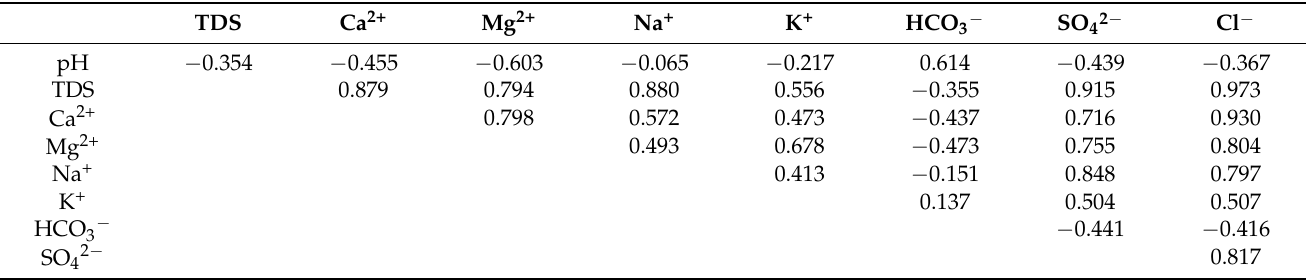
Figure 2. Boxplots of physicochemical parameters and major ions in EOC, NS, and FB aquifers. Table 2. PCC for pH, TDS (mg/L), and major ions (mg/L) in EOC, NS, FB aquifers ( n =